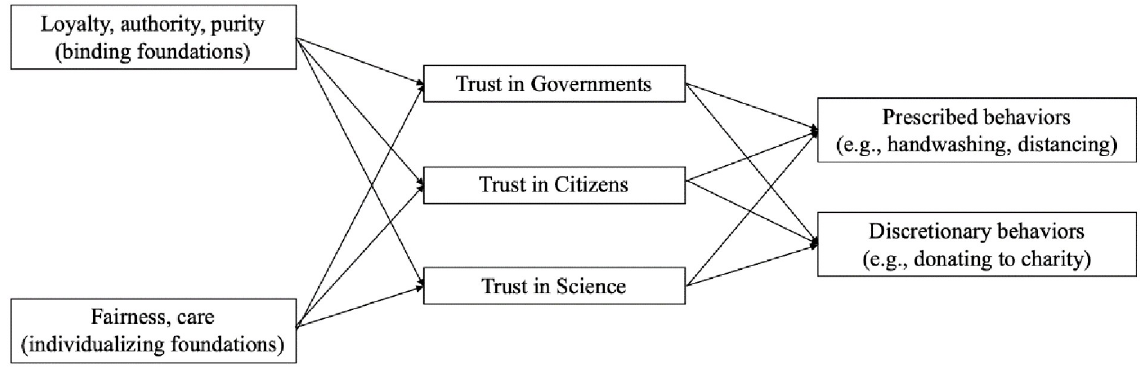
Fig 3. Hypothesized theoretical